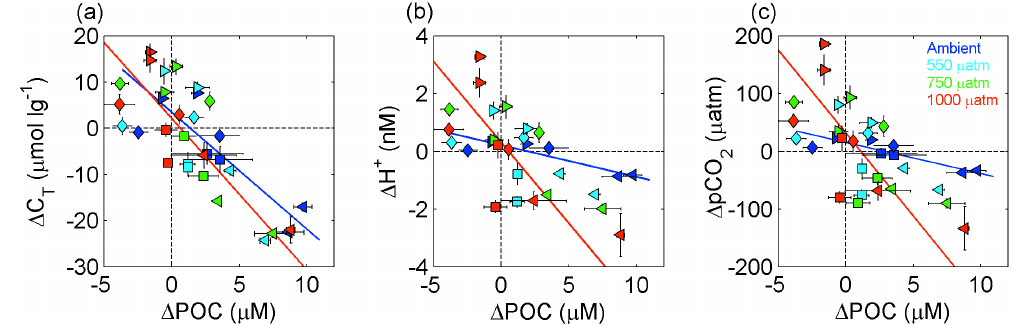
Figure 6. Scatter plots of differences in carbonate chemistry parameters against differences in POC across all time points for the main experiments excluding E1 (i.e. E2-E5): 1C T (µmol kg − 1 ) (a) , 1 H + (nmolL − 1 ) (b) and 1p CO 2 (µatm) (c) are presented as a function of 1 POC (µmolL − 1 ) . Symbol colours indicate target p CO 2 treatment as in Fig. 4. Symbol shapes indicate the experiment number as in Fig. 3: E2 (squares), E3 (diamonds), E4 (left pointing triangles) and E5 (right pointing triangles) with plotted values being means ± 1SE of biological triplicates. Solid lines indicate model II linear regressions for the lowest (ambient: blue) and highest (1000µatm: red) p CO 2 treatments. All regressions are significant ( p < 0.05) with significant differences in slopes between the treatments presented in (b) and (c) . Regression lines for intermediate p CO 2 treatments are omitted for clarity.